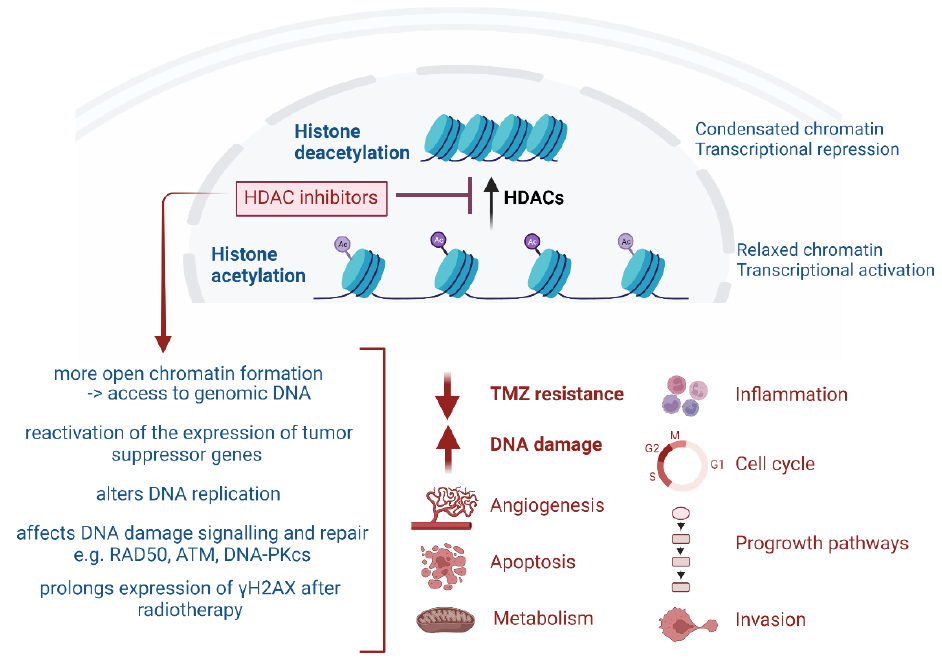
Figure 1. Overview of the broad effects of HDAC inhibitors.